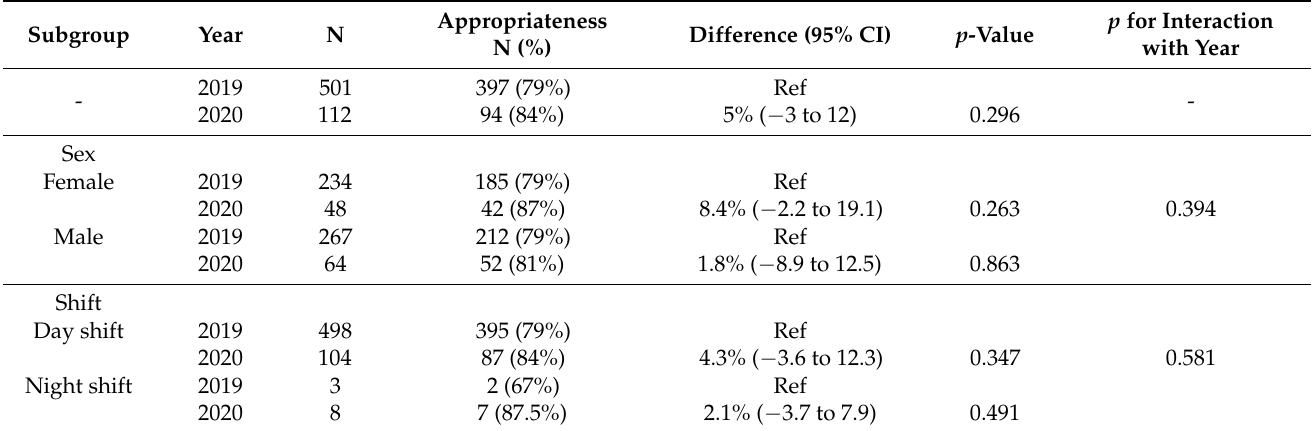
Table 1. Appropriateness of access in the ER by year, overall, and by predefined